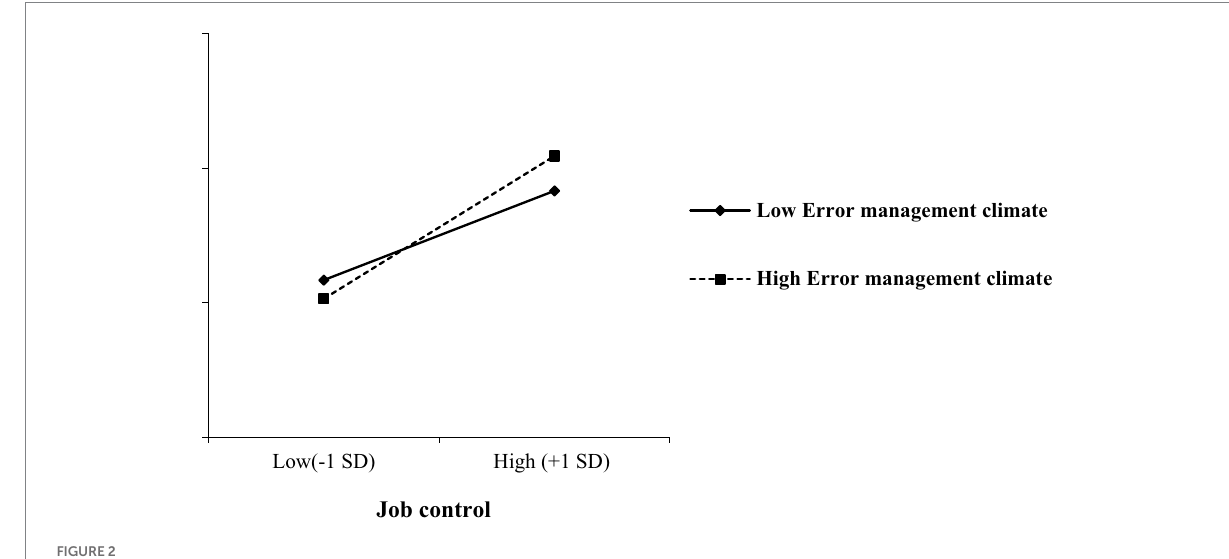
FIGURE 2 Interaction between Job control and EMC on willingness to take